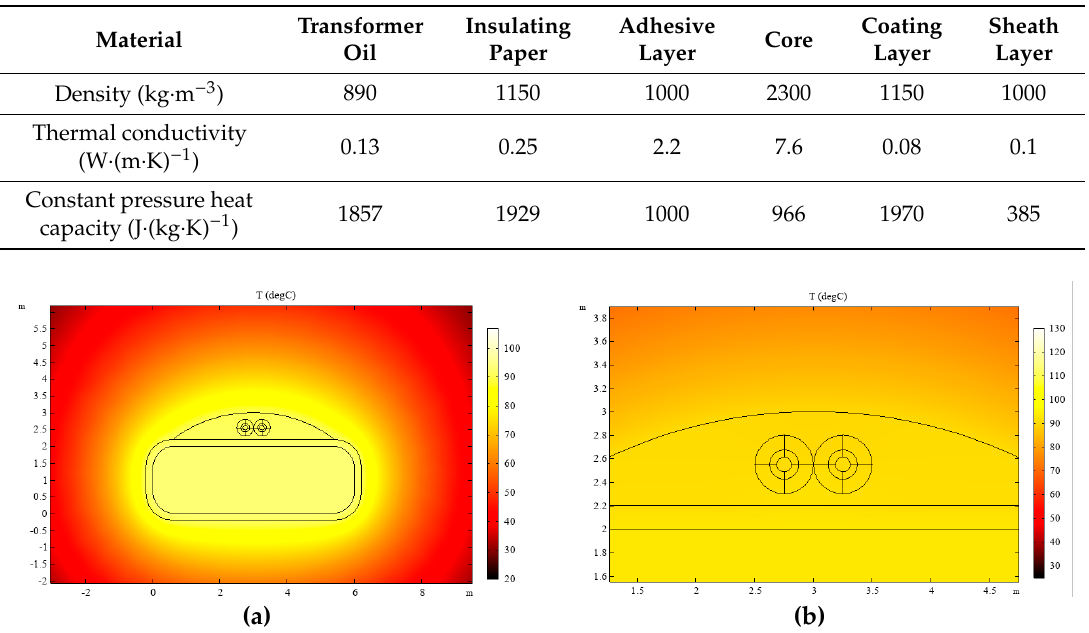
Table 3. Model parameters for temperature field simulation.